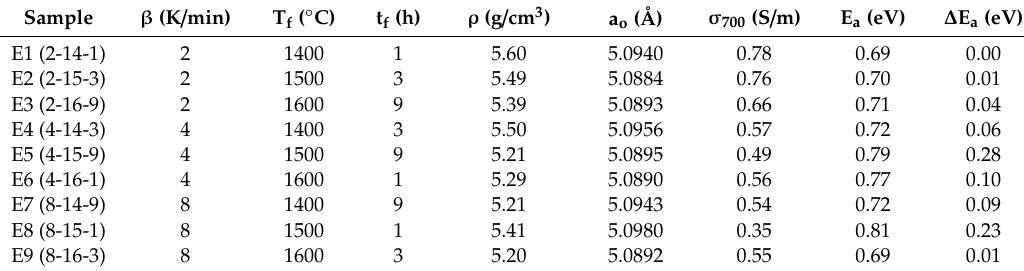
Figure 1. Representative example of a firing schedule with identical heating / cooling rates (E(4 4-14-3) in Table 1). Table 1. Taguchi planning of firing schedules and impact of heating / cooling rate ( β ), firing temperature (T f ) and firing time (t f ) on experimental density, lattice parameter of cubic phase (a o ), electrical conductivity at 700 ◦ C and activation energy (E a ). The relative increase of activation energy at temperatures above 800 ◦ C ( ∆ E a ) is also